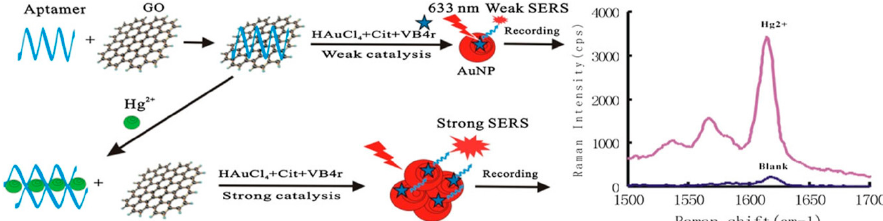
Figure 3. Scheme of aptamer-regulated graphene oxide (GO) catalysis and SERS detection of Hg 2+ using VB4r as a molecular probe. (Reprinted with permission from Wiley, 2018 [61]).